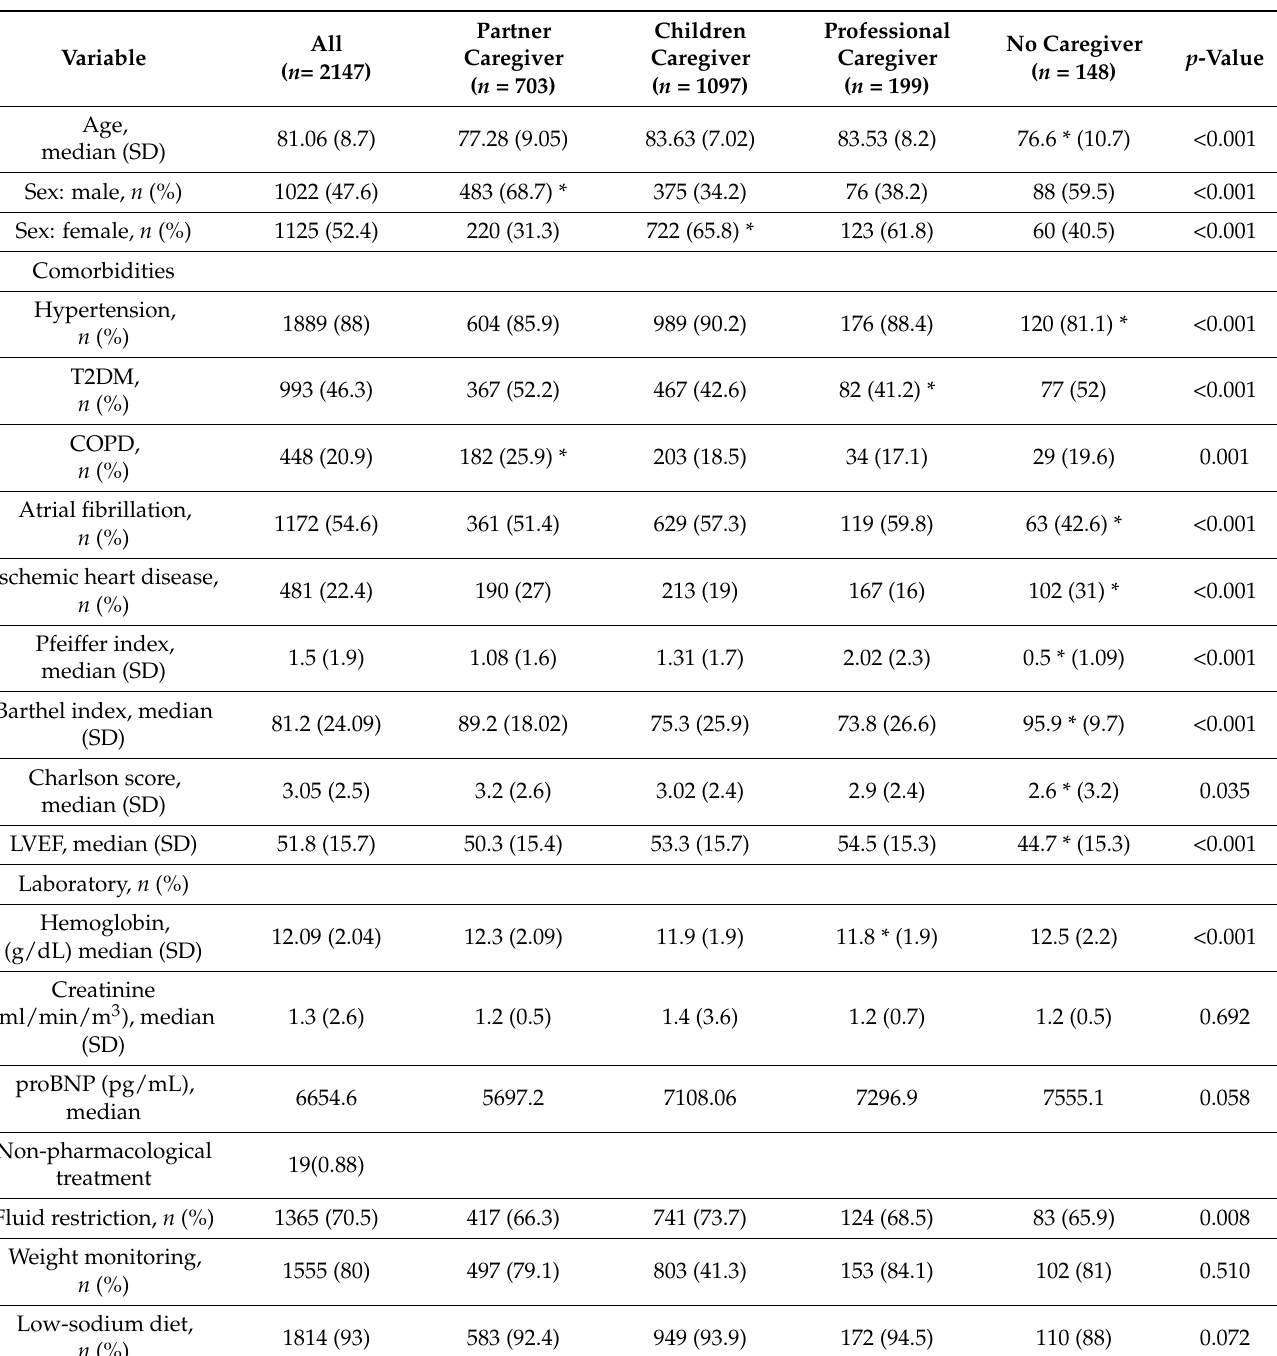
Table 1. Baseline characteristics and outcomes of patients with HF according to